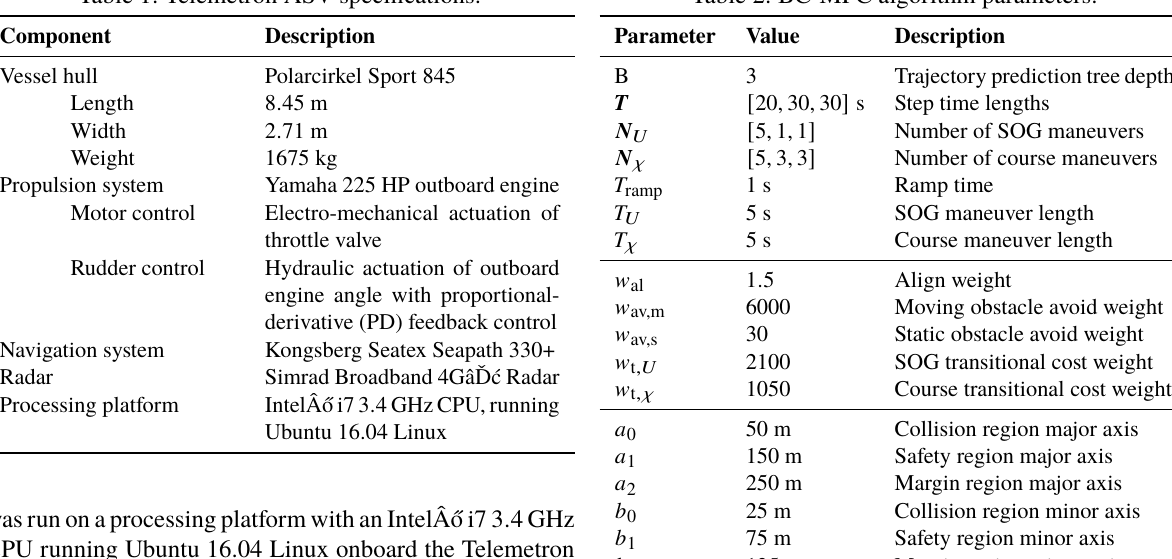
Table 1: Telemetron ASV specifications. Table 2: BC-MPC algorithm